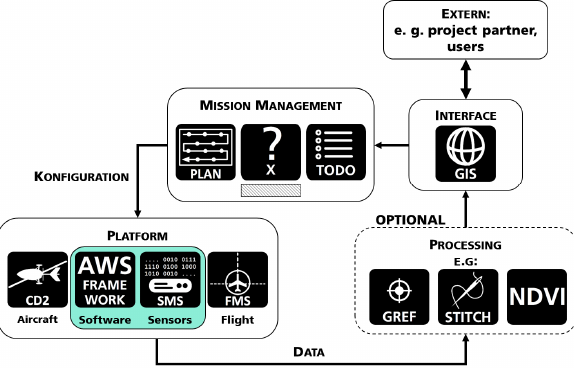
Figure 2. Schematic overview of the general workflow for mission